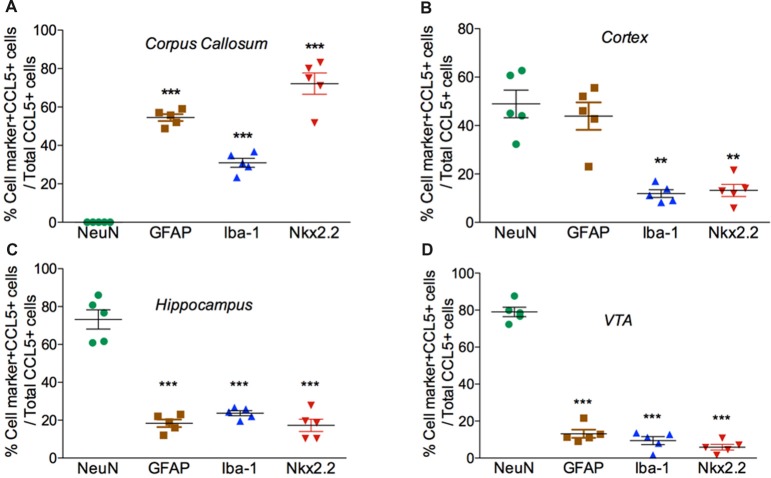
Cell expression of CCL5 mRNA follows an anatomical profile. Quantifications of CCL5 mRNA puncta within cells were performed on a series of five randomly selected coronal sections per rat, throughout the corpus callosum (A), cerebral cortex (B), hippocampus (C), and VTA (D). Data, represented as the mean ± SEM, are expressed as the average of double-stained cells compared to the total number of CCL5 mRNA positive cells per animal (n = 5). **p < 0.01; ***p < 0.001 neurons vs. glial cell types.